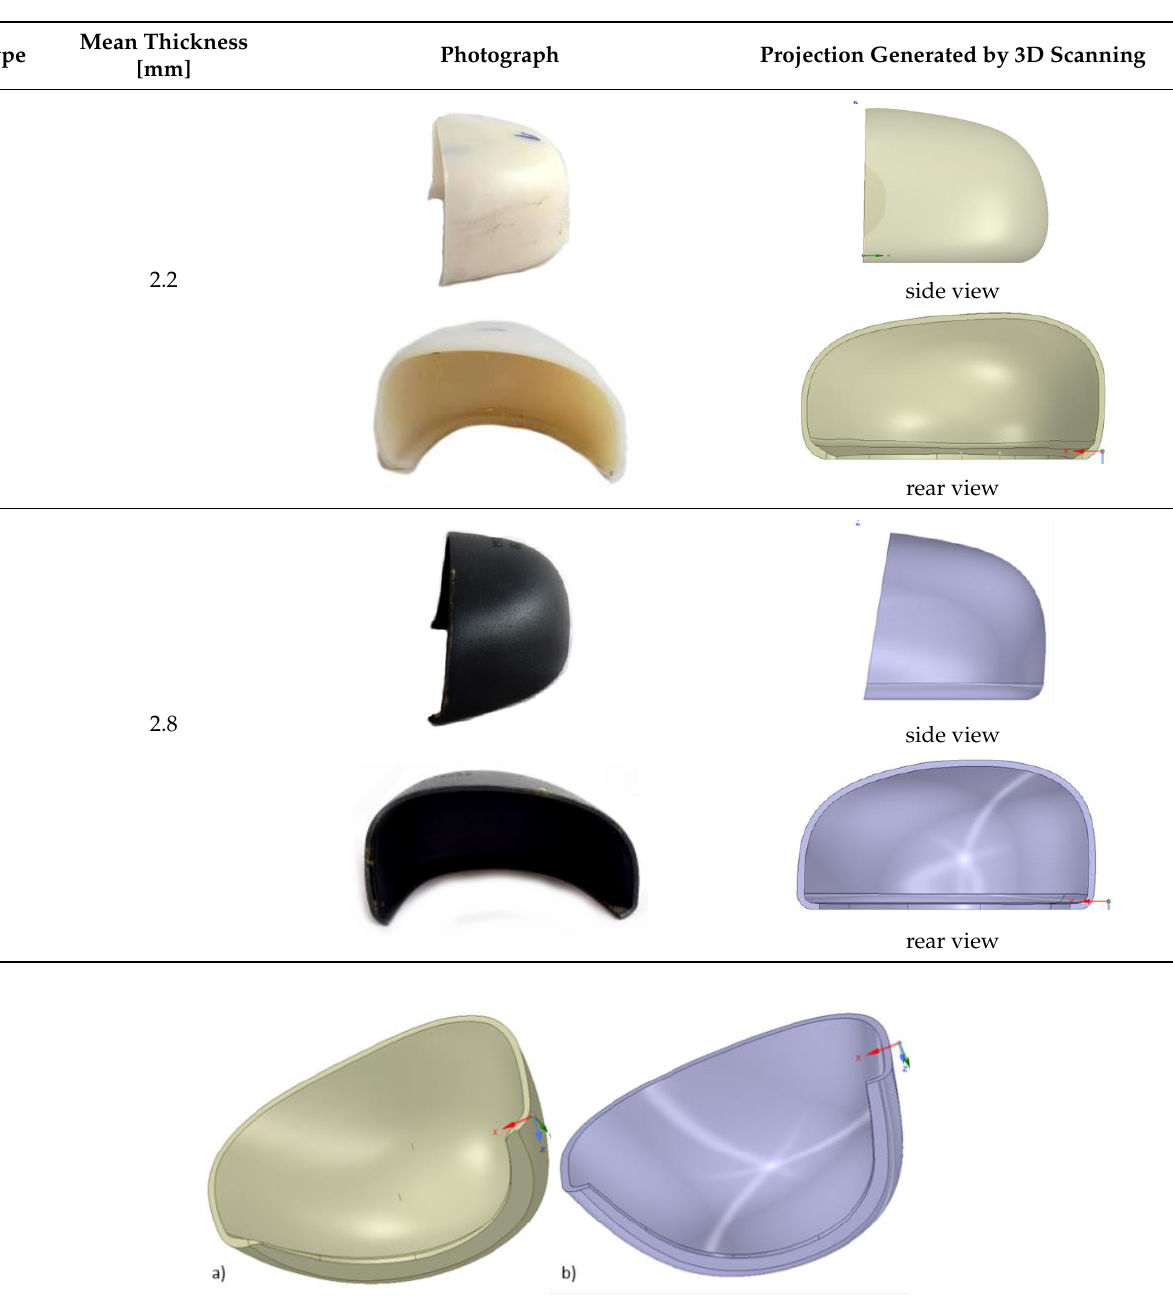
Table 1. Tested toecaps.